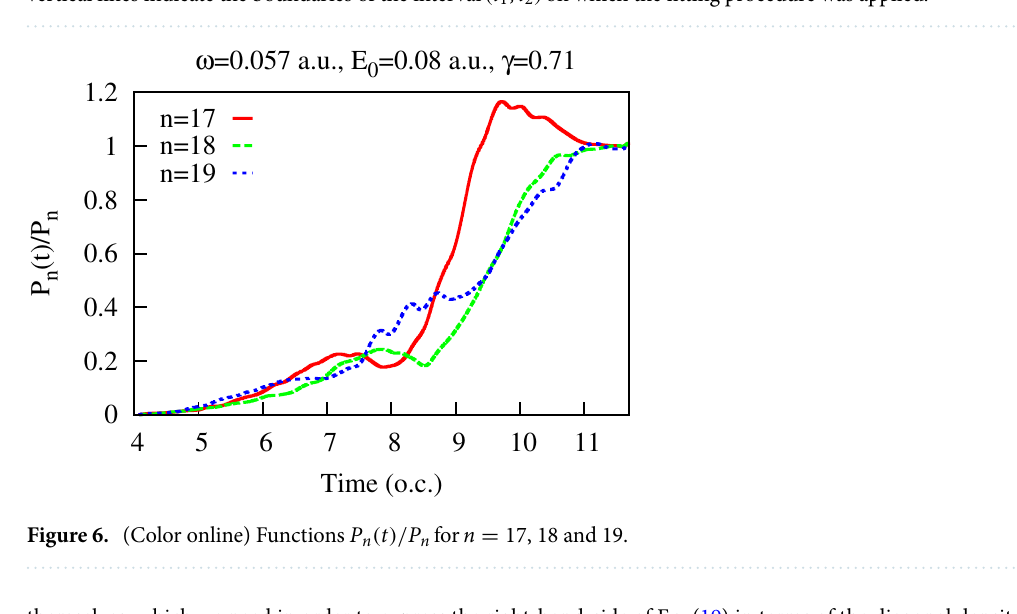
17 and n 18 . Dashed = =